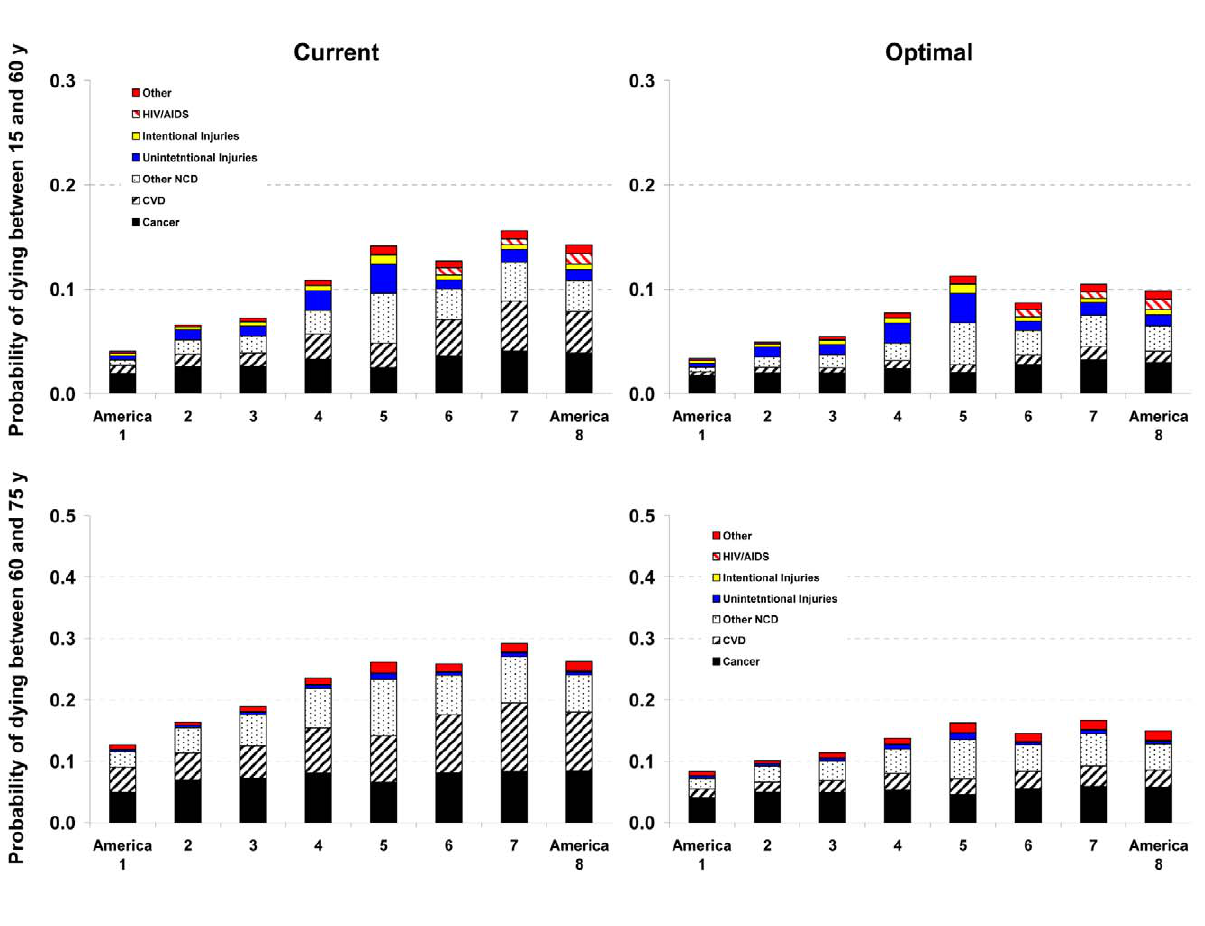
Figure 3. Probability of death from different medical causes between 15 and 60 years of age ( 45 Q 15 ) and between 60 and 75 years of age ( 15 Q 60 ) in the current and optimal distributions of risk factors in the Eight Americas in women. See definitions of the Eight Americas in Table 1.